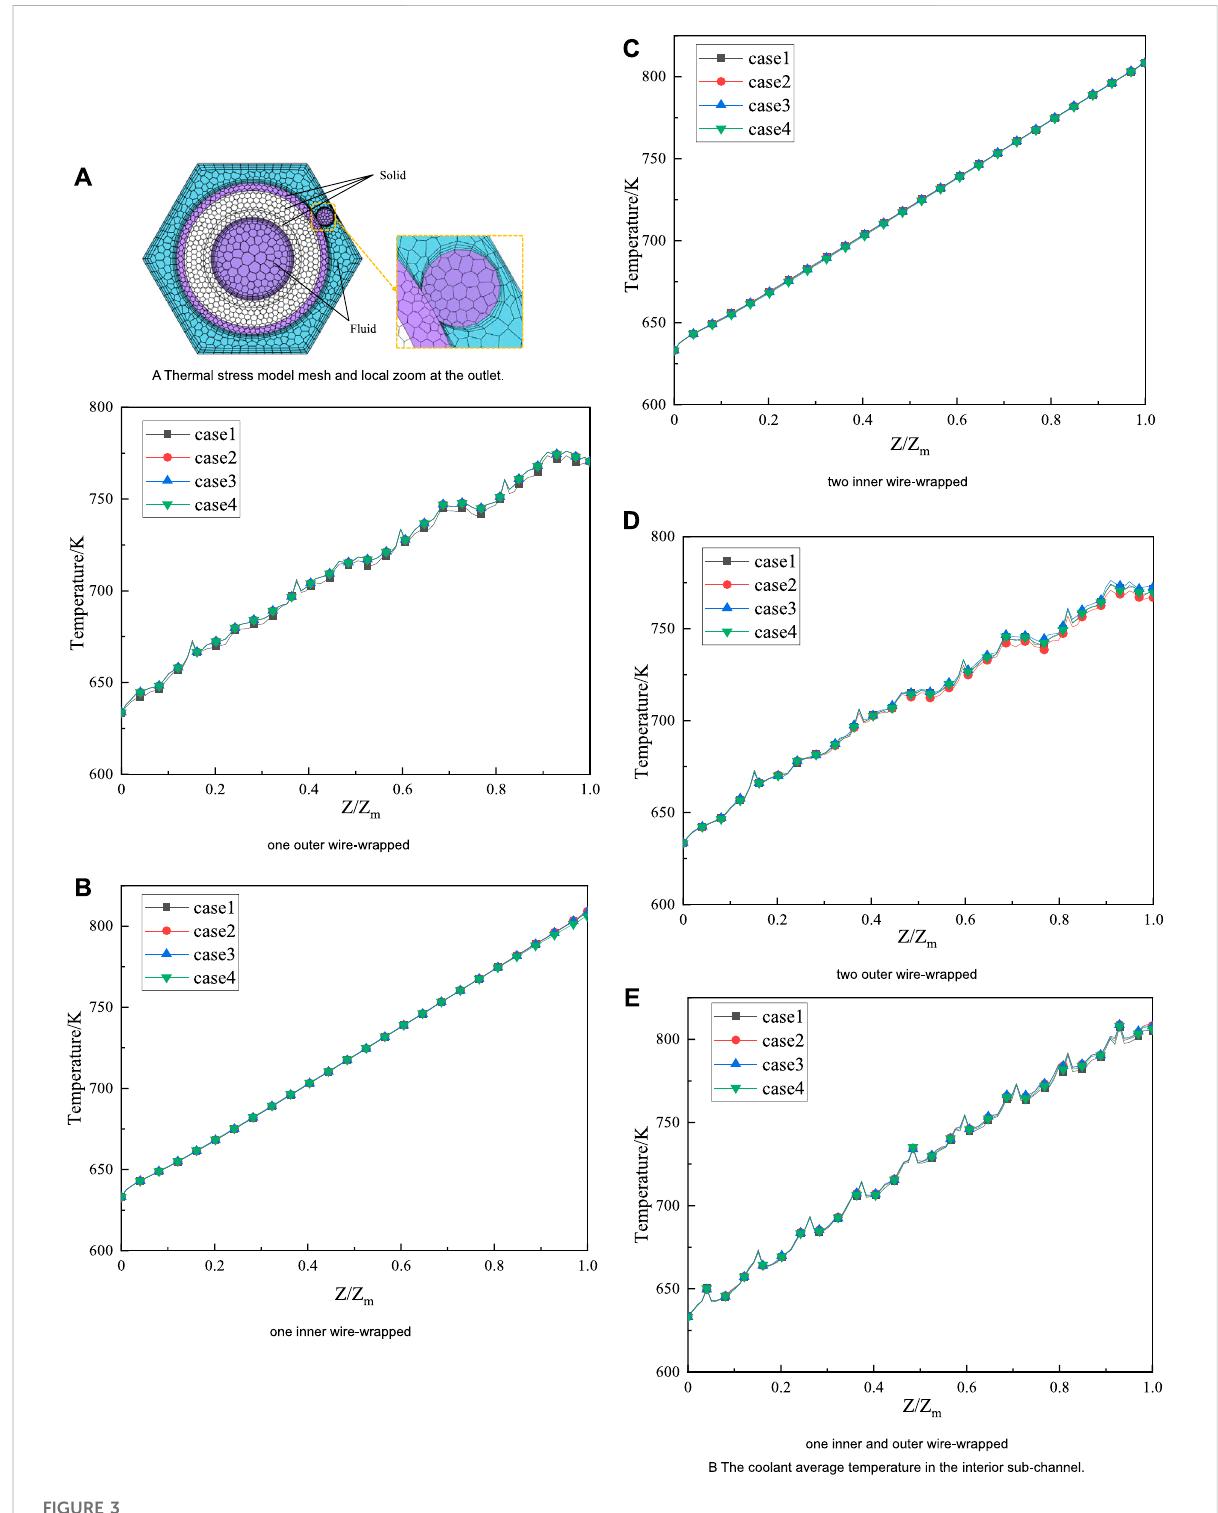
FIGURE 3 Mesh models and grid independence